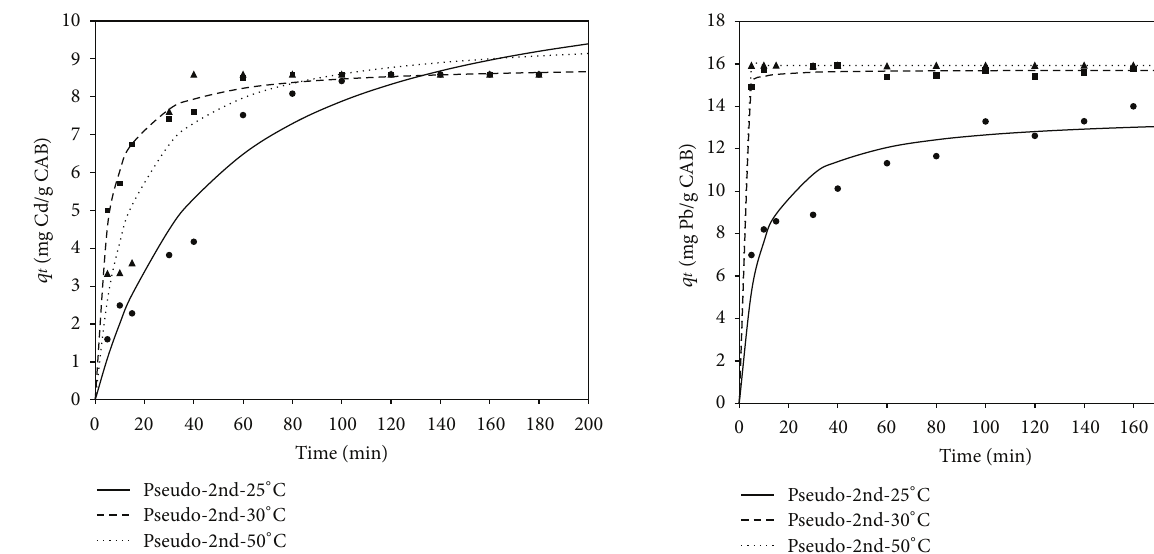
Figure 4: Adsorption capacity ( 𝑞 𝑡 ) of lead by CAB at different temperatures ( ∘ C) versus time (min), adjusted to a pseudo-second- order